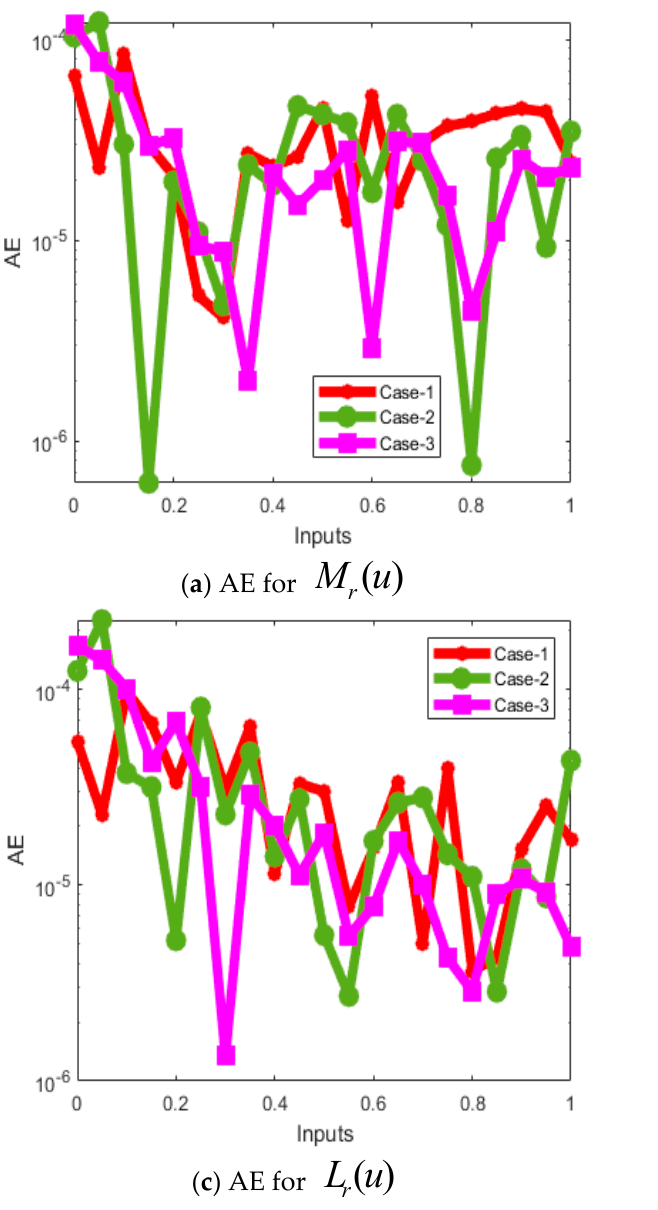
Figure 7. AE performances to solve the FO-MML love story model using the SCGNNs.